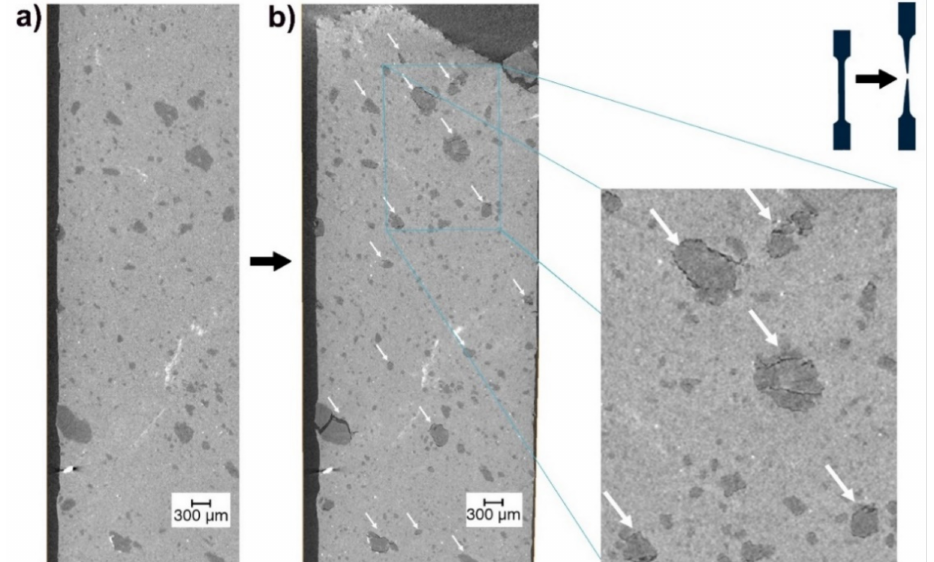
Figure 9. Representative X-ray computed tomography slices of vulcanized rubber compound filled with 50 phr of CB and 20 phr of PIBOMA ( M n = 283,000 g mol − 1 ) before ( a ) and after its tensile testing ( b ). White arrows are for indication of the decohesion